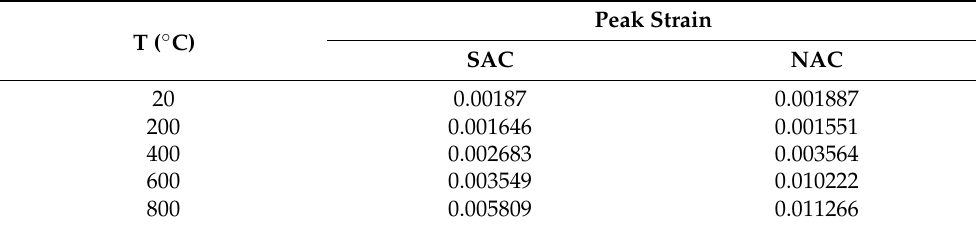
Table 3. Peak strain of concrete after different